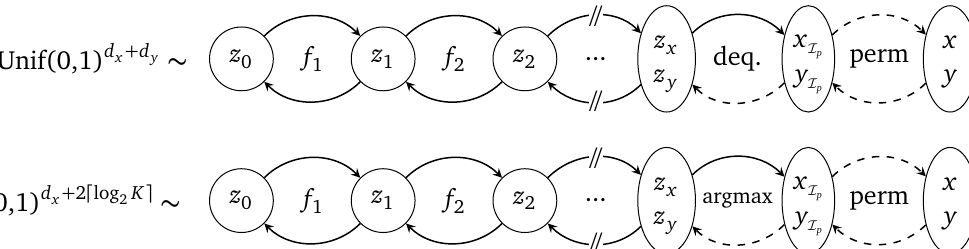
Figure 9: The variational dequantization and argmax surjection transform architec- tures described in sections 3.5.1 and 3.5.2. The permutation transform can either be a stochastic permutation or a sort surjection, in which case the arrow in the inverse direction would be